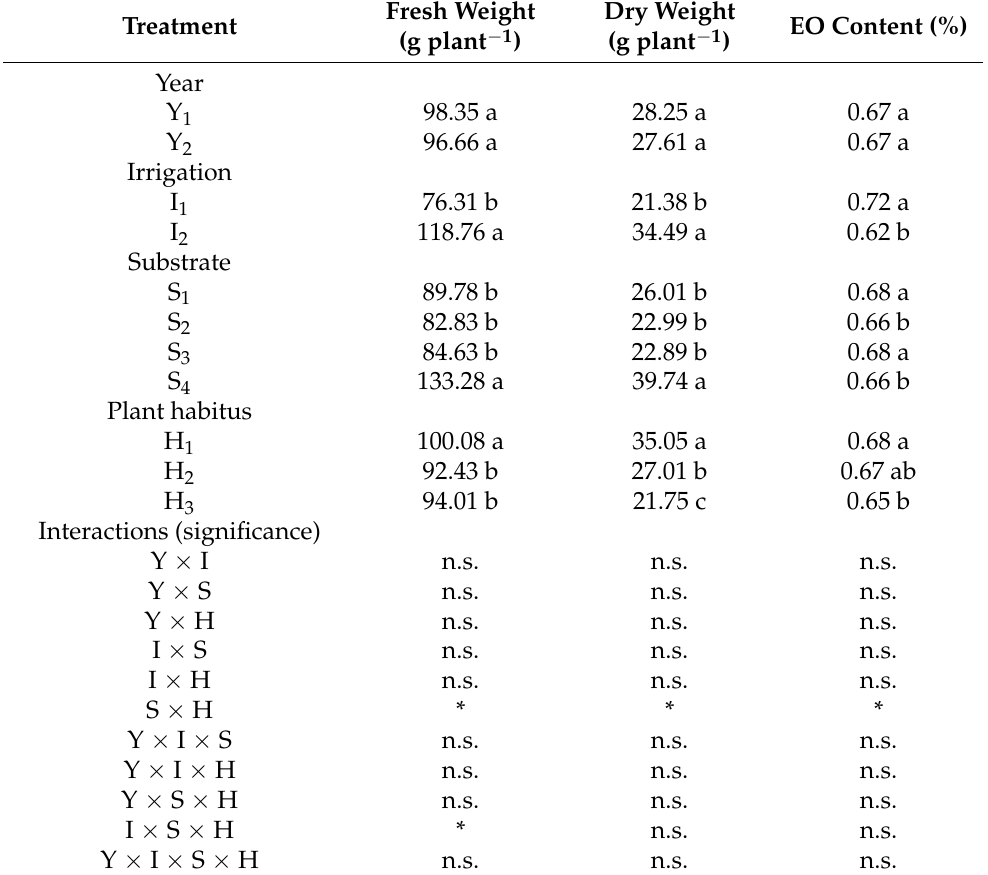
Table 3. Production characteristics of rosemary plants in response to year, irrigation, peat-alternative substrate and plant